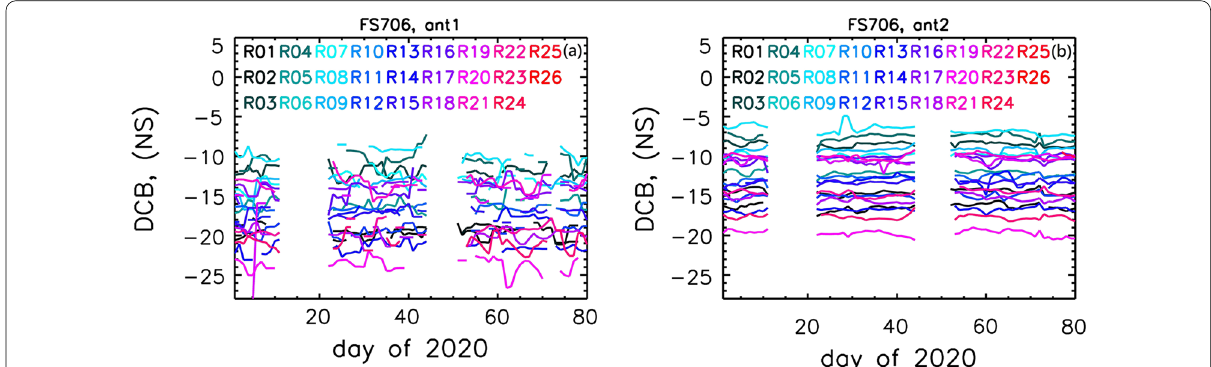
Fig. 7 DCB variations of GLONASS signal of F7/C2 FS706 satellite from day of year 001 to 080 in 2020. Panel ( a ) and ( b ) are for antenna 1 and antenna 2, respectively